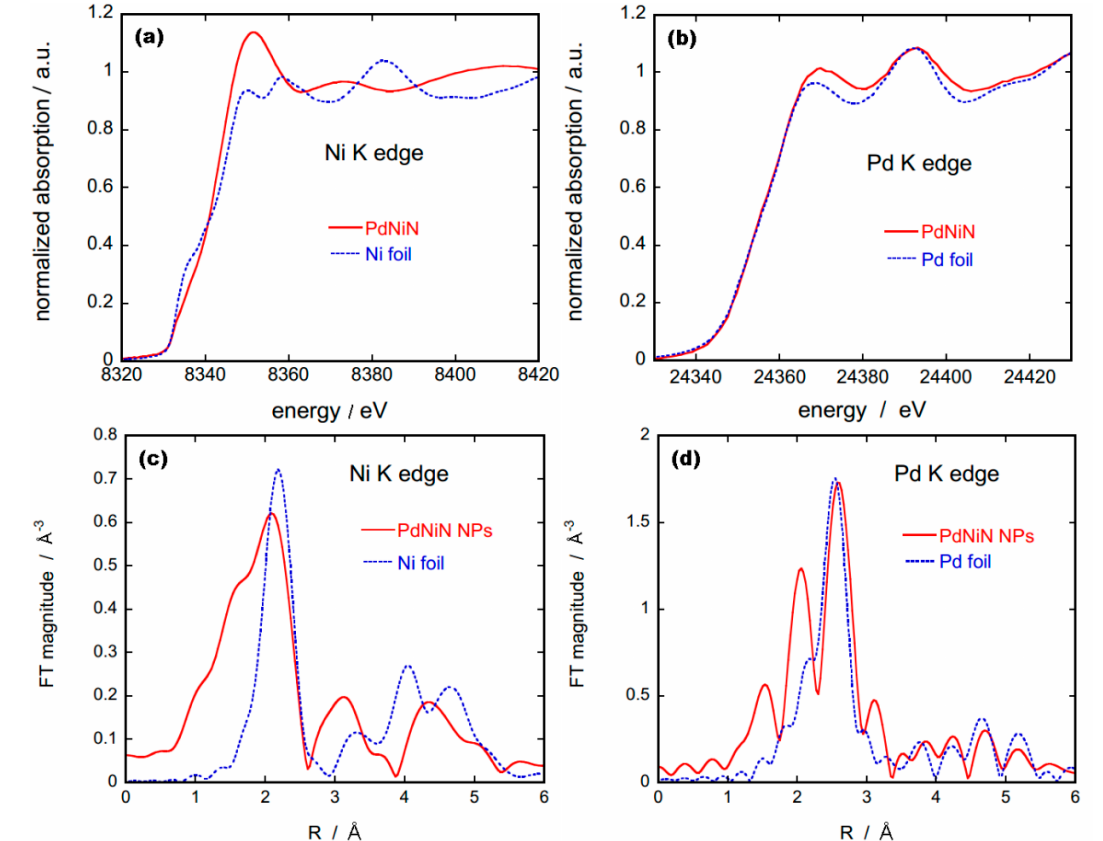
Figure 2. ( a , b ) Normalized XANES spectra for Ni and Pd K edges respectively along with Ni and Pd reference foil; ( c , d ) FT EXAFS spectra for Ni and Pd K edges respectively along with their reference